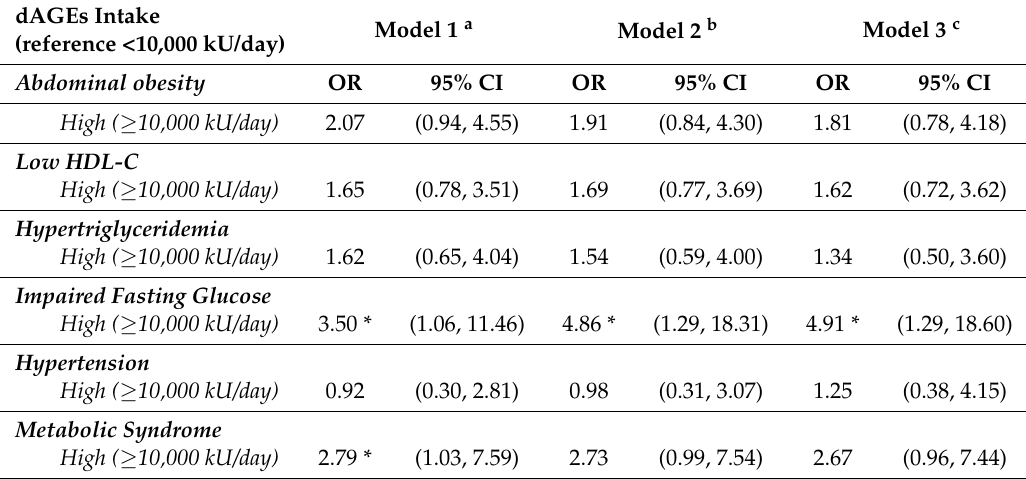
Table 3. Multivariate analysis for metabolic syndrome and its components according to high dAGEs